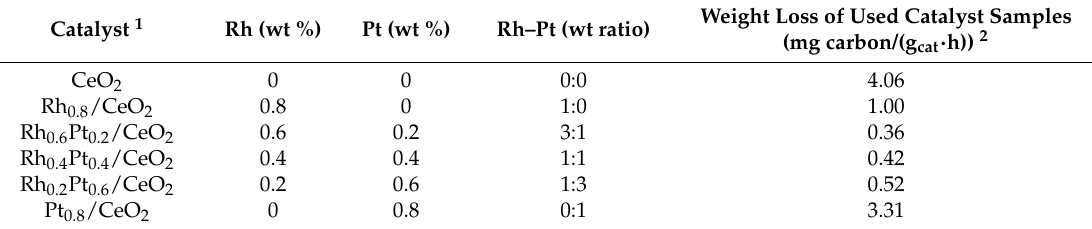
Table 2. RhPt/CeO 2 catalysts evaluated in steam reforming of ethanol